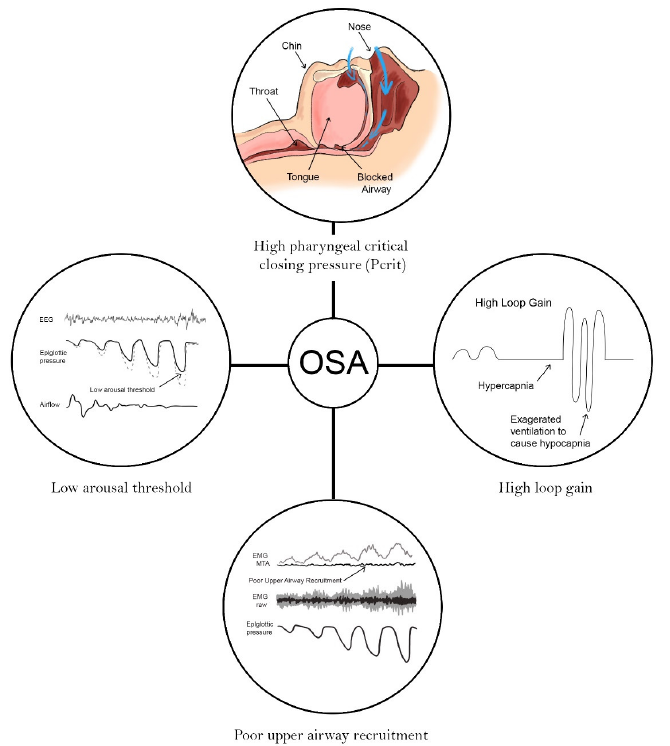
Figure 3. Four phenotypes/endotypes in obstructive sleep apnea hypopnea syndrome (OSAHS), modified from Eckert et al. [34,35]. Treatment outcomes for the patient are strongly influenced by whether or not treat- ment is tailored to the phenotypes of the individual. For instance, a patient with high loop gain will not respond favorably to MAD [5]. The importance of this should not be under- estimated. Eckert demonstrated that pathophysiological traits varied substantially be- tween patients with the same condition. Of those patients with OSAHS, 36% had minimal genioglossus muscle responsiveness during sleep, 37% showed a low arousal threshold, 36% had high loop gain and 26% demonstrated compound nonanatomic features [34]. Craniofacial structure and pharyngeal anatomy play an important role. Overall, the upper airway is more collapsible in patients with OSAHS. However, Eckert found that 19% of his OSAHS subjects had a comparatively non-collapsible upper airway, similar to many of the controls. In these patients, loop gain was almost two times higher than it was in patients with a highly collapsible airway [34,35].